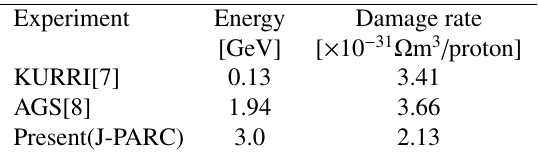
Figure 2. Schematic drawing of equipments utilized in the present experiment. Table 1. Characteristics of copper sample. Table 2. Experimental resistance change rate to one proton